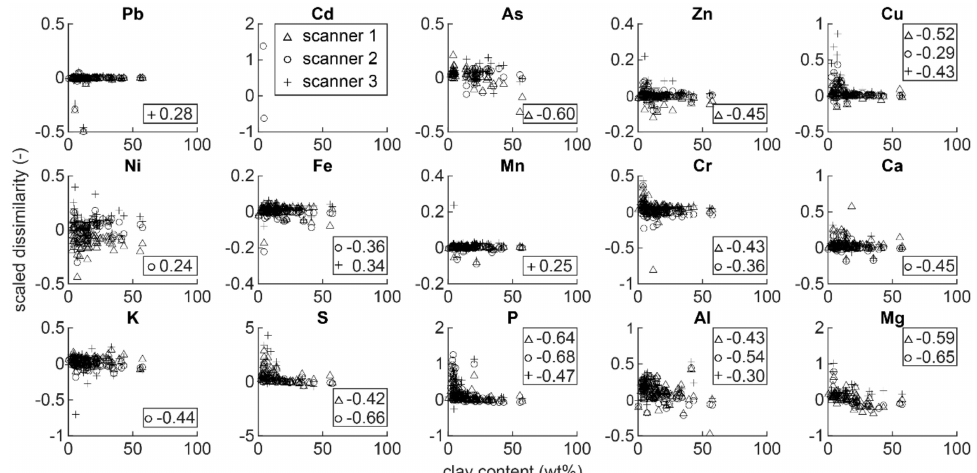
Figure 8. E ff ect of clay content on X-ray fluorescence (XRF) performance. Scatterplots of the scaled dissimilarities for all samples and all scanners versus the samples’ clay contents. Significant (5% significance level) Spearman correlations between the scaled dissimilarities and the clay contents are shown for each